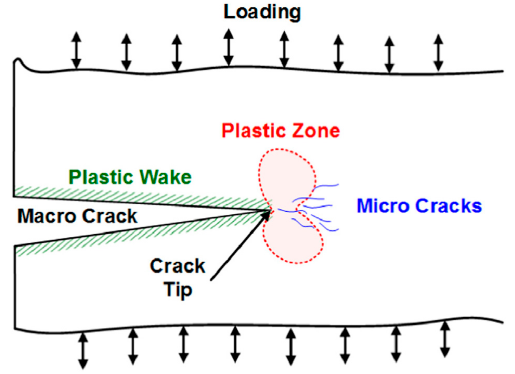
Figure 1. Formation of macro- and micro-cracks (Lim et al., 2015 [6]).